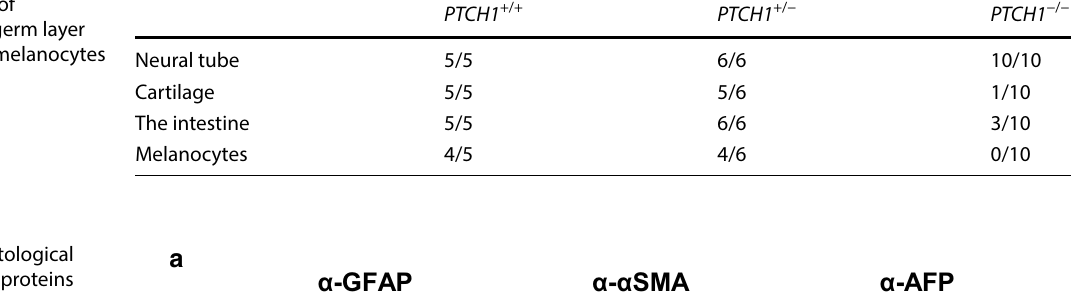
Fig. 4 Immunohistological analysis of marker proteins in teratomas. a The expres- sion of the germ layer marker proteins, GFAP, αSMA, and AFP, was immunohistochemi- cally analyzed in a PTCH1 +/+ teratoma (G11 PTCH1 +/+ ) (upper column) and PTCH1 −/− teratoma (G72 PTCH1 −/− ) (lower column). Scale bar: 100 μm. b Expression of the marker proteins for medullo- blastoma. A series of sections of a PTCH1 −/− teratoma (G36 PTCH1 −/− ) were stained with anti-synaptophysin, anti- βIII tubulin, and anti-Ki67 antibodies. Scale bar: 60 μm. c Medulloblastomas occupied a larger area in PTCH1 −/− teratomas than in PTCH1 +/− teratomas. The percentage of areas of medulloblastoma-like tissues positive for βIII tubulin, synaptophysin, and Ki67 was calculated in PTCH1 +/− and PTCH1 −/− teratomas. Closed circles and error bars represent the mean ± SEM ( PTCH1 +/− ; n = 5, PTCH1 −/− ; n = 9 ). Open circles represent each